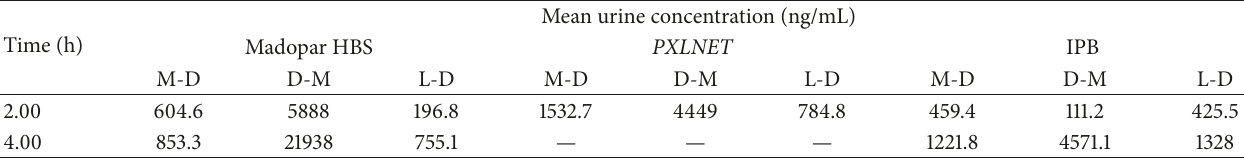
Table 7: Mean urine concentration after oral administration of Madopar HBS capsules, PXLNET , and IPB matrices. Time (h)